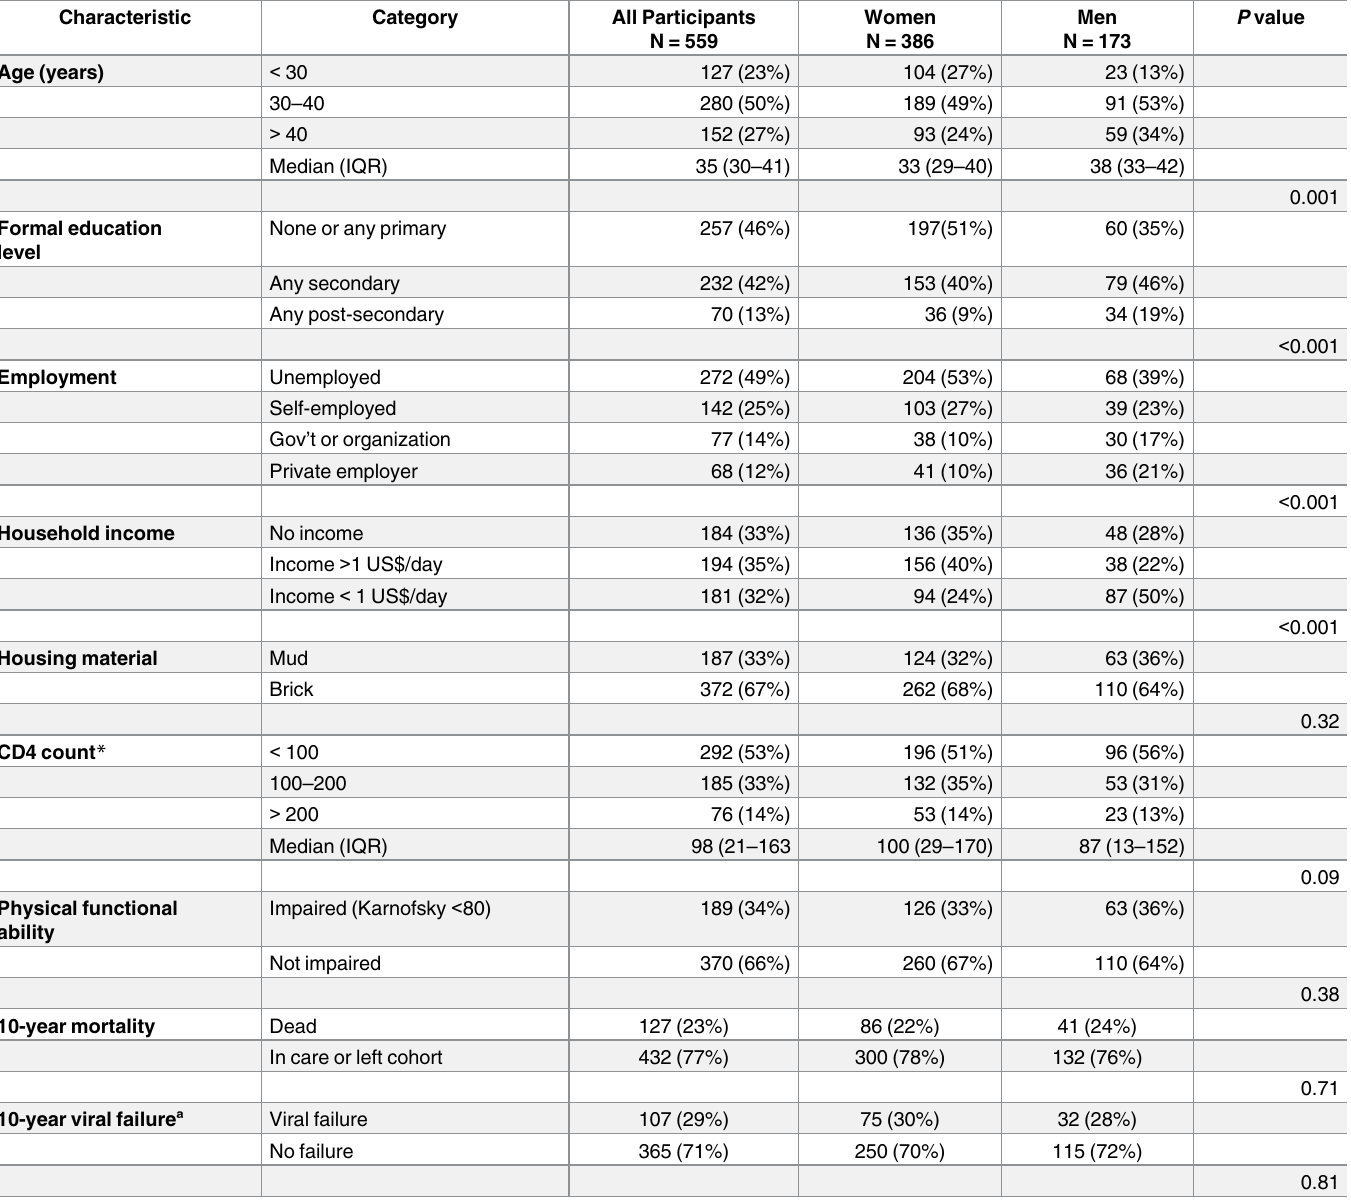
Table 1. Cohort descriptive